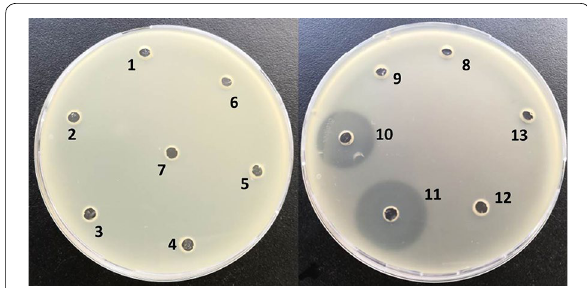
Fig. 2 The antibacterial activity of the elution gradient of silica gel column chromatography. Antimicrobial activity of five fractions of ethyl acetate phase of GN59 fermentation broth the number 1, 2, 3, 4, 5 represents different fractions eluted by eluents (petroleum ether:ethyl acetate 100:0; petroleum ether:ethyl acetate 75:25; petroleum ether:ethyl acetate 50:50; petroleum ether:ethyl acetate